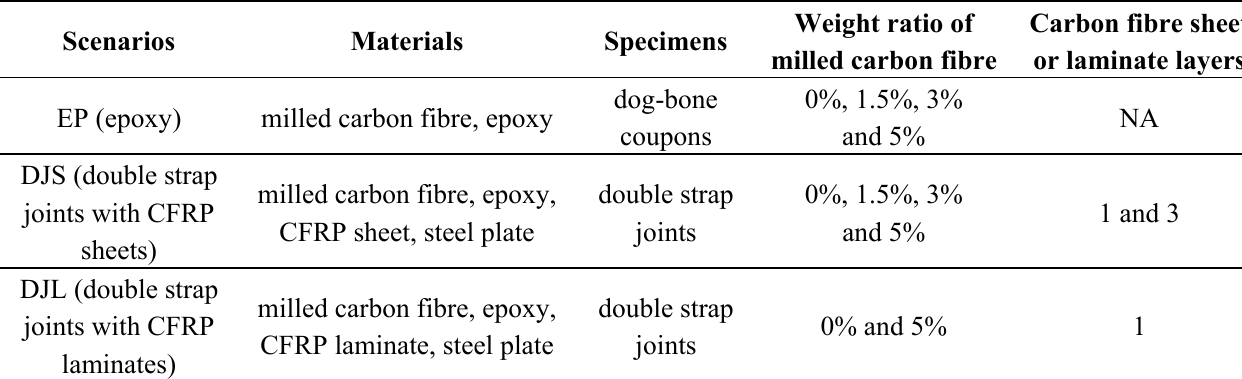
Table 1. Mechanical experiments and key